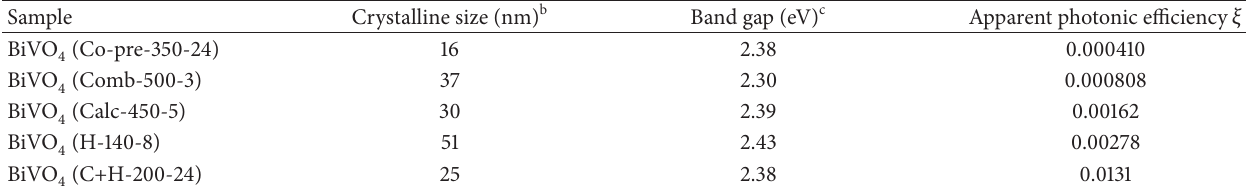
Table 4: Properties and photocatalytic performance of BiVO 4 samples prepared via various synthesis methods.